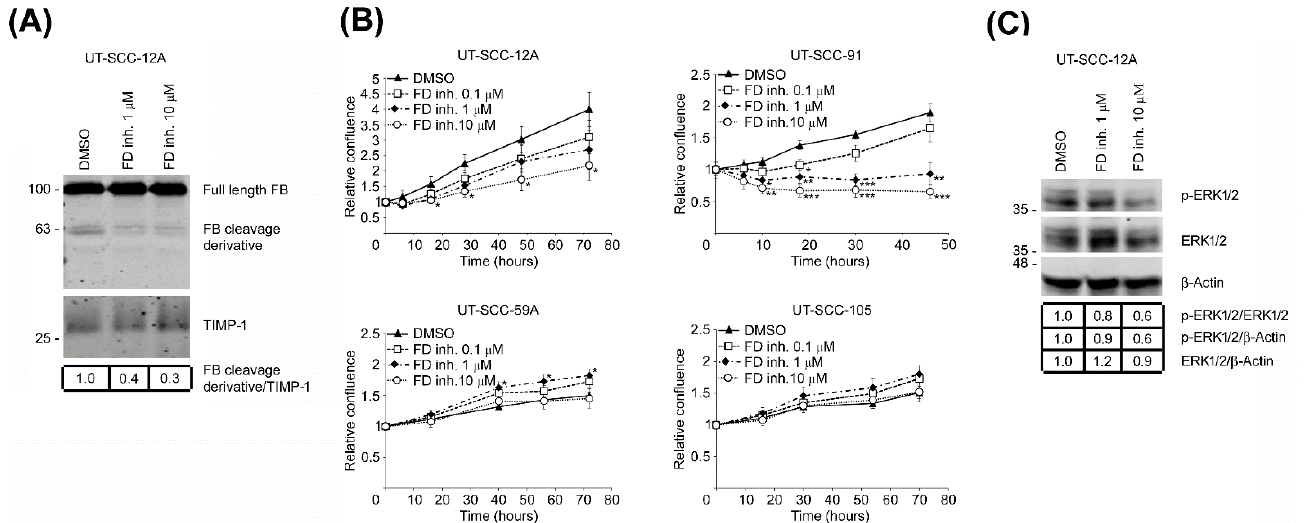
Figure 5. Targeted inhibition of FD suppresses the proliferation of cSCC cells through blockade of ERK1/2 activation. ( A ), cSCC cell cultures (UT-SCC-12A) were treated with a small-molecule factor D inhibitor (danicopan; ACH-4471) or DMSO as vehicle control for 24 h. The levels of complement factor B (FB) and its 60 kDa cleavage derivative in conditioned media of cSCC cells were determined by Western blot analysis. TIMP-1 was used as a loading control. Migration positions of molecular weight markers in kDa are shown on the left, The uncropped immunoblot images can be found in Figure S4. ( B ), cSCC cells with high basal FD expression (UT-SCC-12A and -91) and with low basal FD expression (UT-SCC-59A and -105) were treated with small-molecule FD inhibitor (danicopan; ACH-4471) or DMSO as vehicle control. Targeted inhibition of FD significantly suppressed cell proliferation, specifically in cSCC cell lines with high expression of FD protein (UT-SCC-12A and-91), whereas no similar effect was observed on cSCC cells with low FD protein expression (UT-SCC-59A and-105). Results of cell proliferation assays after targeted FD inhibition using IncuCyte S3 real-time cell imaging system are shown. * p < 0.05, ** p < 0.01, *** p < 0.001; two-tailed t -test. ( C ), Levels of phosphorylated ERK1/2 (p-ERK1/2) and ERK1/2 in small-molecule factor D inhibitor (danicopan; ACH-4471) or DMSO vehicle-treated cSCC cell lysates were determined by Western blot analysis 24 h following targeted FD inhibition. β -Actin was used as a loading control. Migration positions of molecular weight markers in kDa are shown on the left, The uncropped immunoblot images can be found in Figure S5.